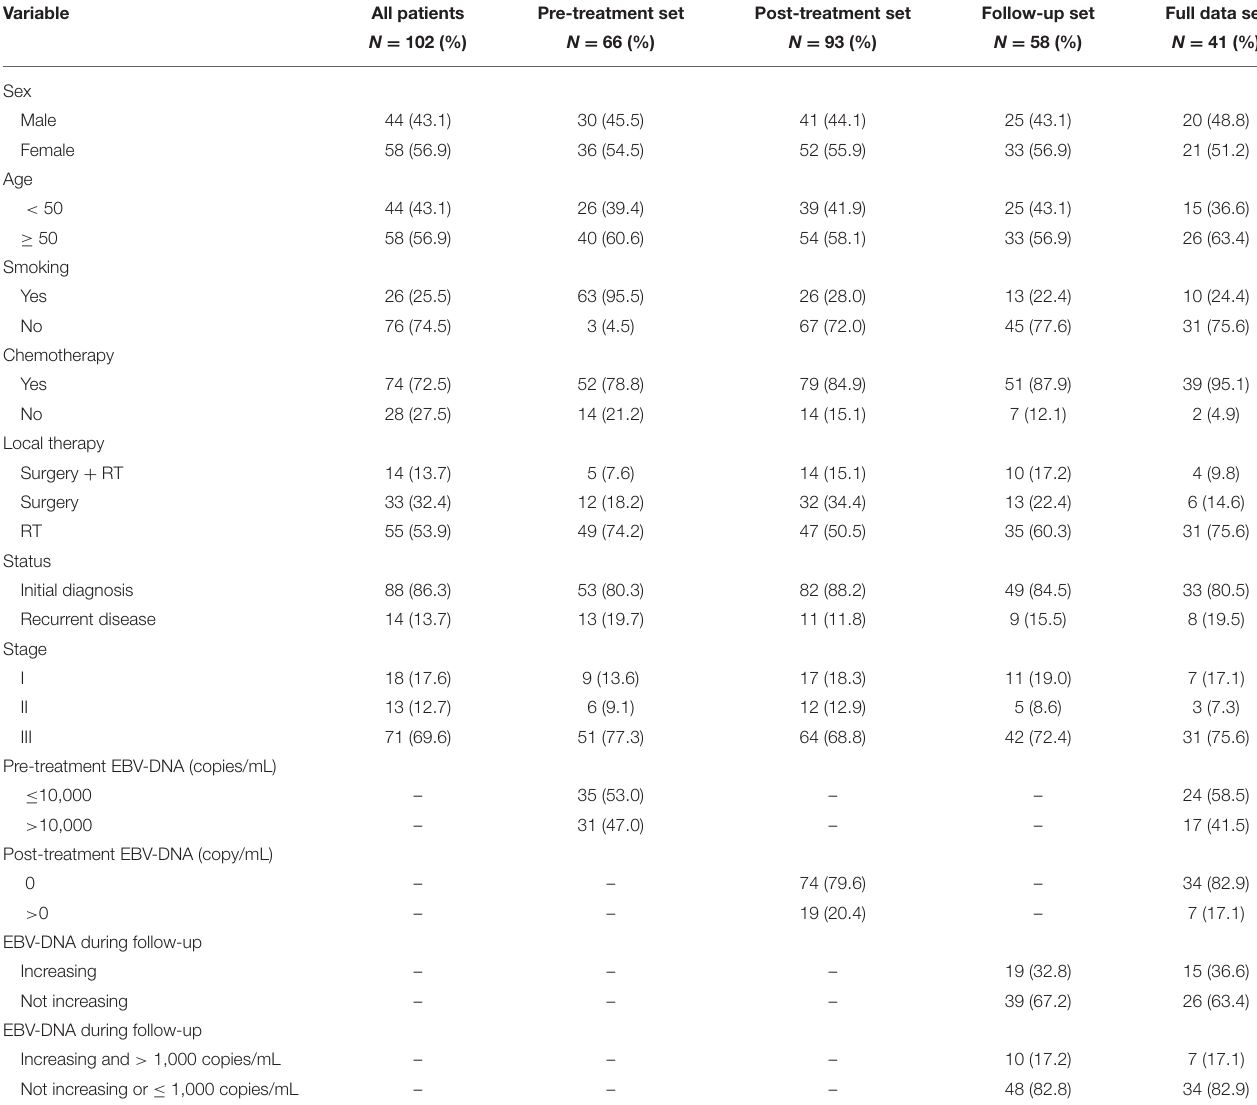
TABLE 1 | Patient